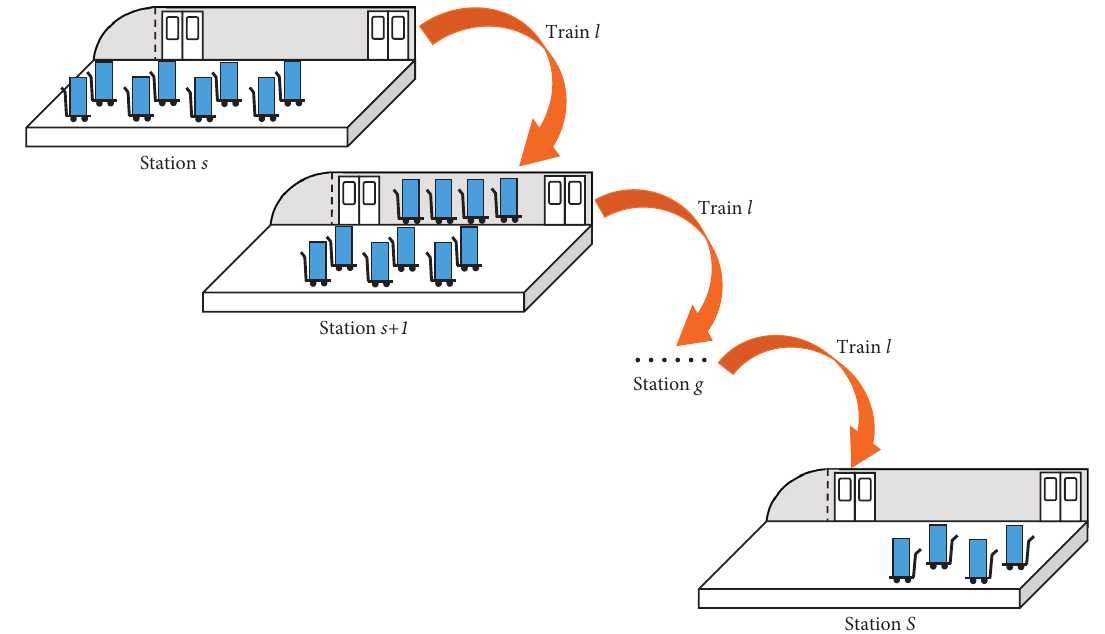
Figure 2: The process of a single metro line with one freight carriage.